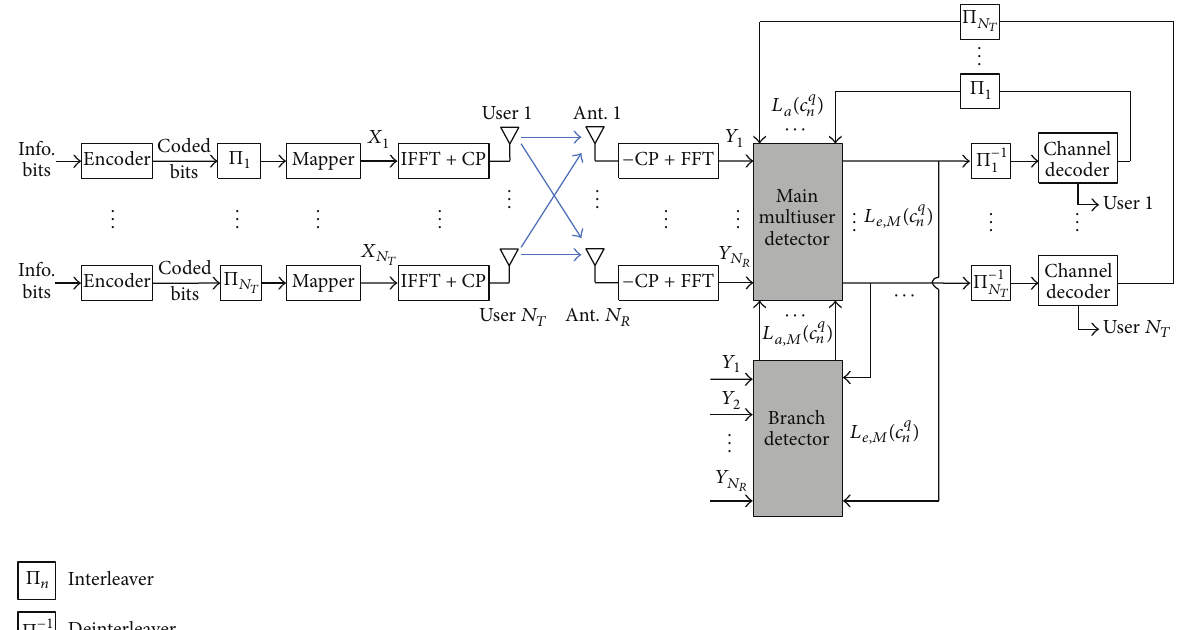
Figure 2: Block diagram of the coded large-scale multiuser MIMO-OFDM system with iterative detector at the receiver.